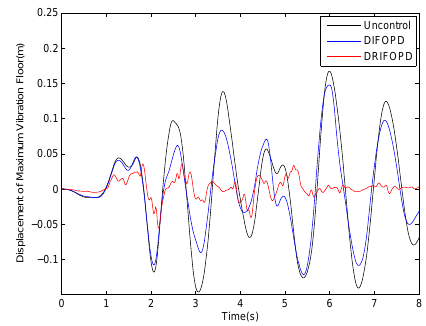
Figure 15. The displacement of the maximum vibration floor under fault case 3.